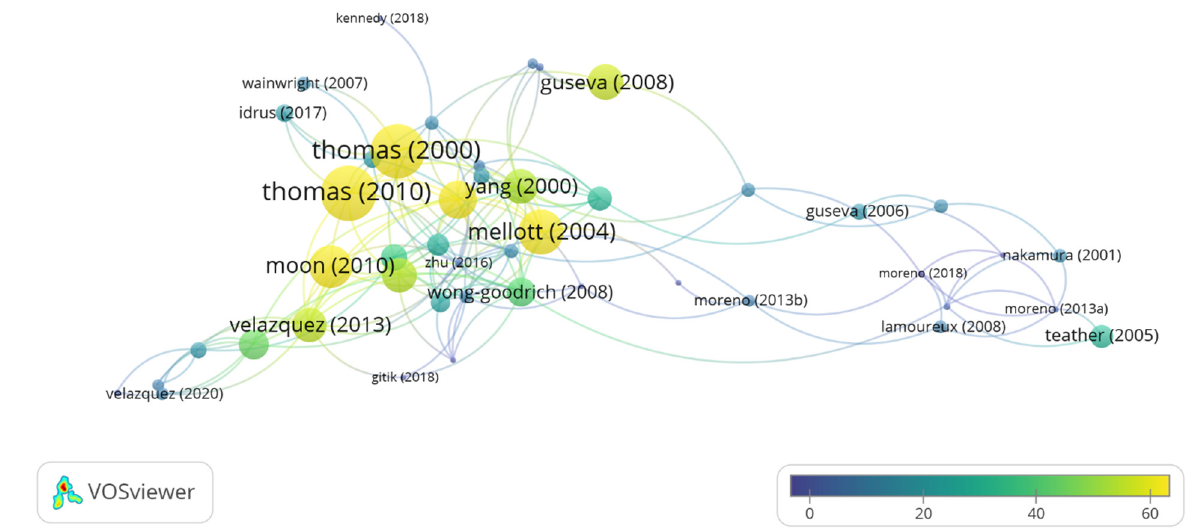
Figure 6. Network data map of the articles’ citations. The point size and color represent the number of citations received. The lines represent the number of co ‐ citations.